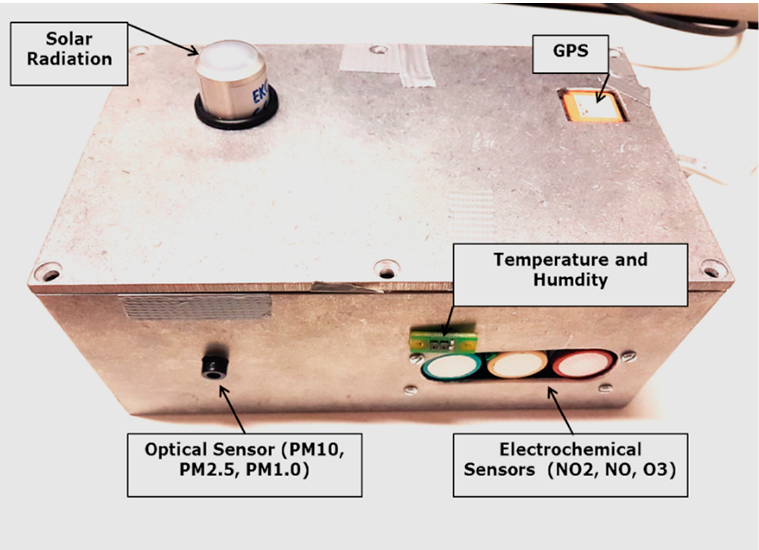
Figure 2. URBMOBI 3.0 device for mobile air quality and meteorology with sensors for fine dust (OPC-N2), gases (NO 2 , NO, and O 3 ), air temperature, and humidity (SHT35), and global radiation (EKO ML-01); Photo: Janani Venkatraman Jagatha.